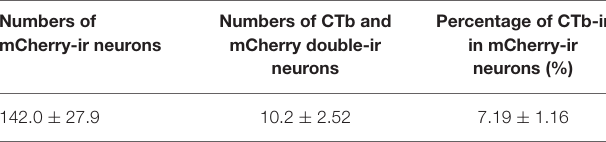
TABLE 1 | Numbers and percentages of mCherry and CTb-immunoreactive neurons in the NAc after CTb injection into the LH.